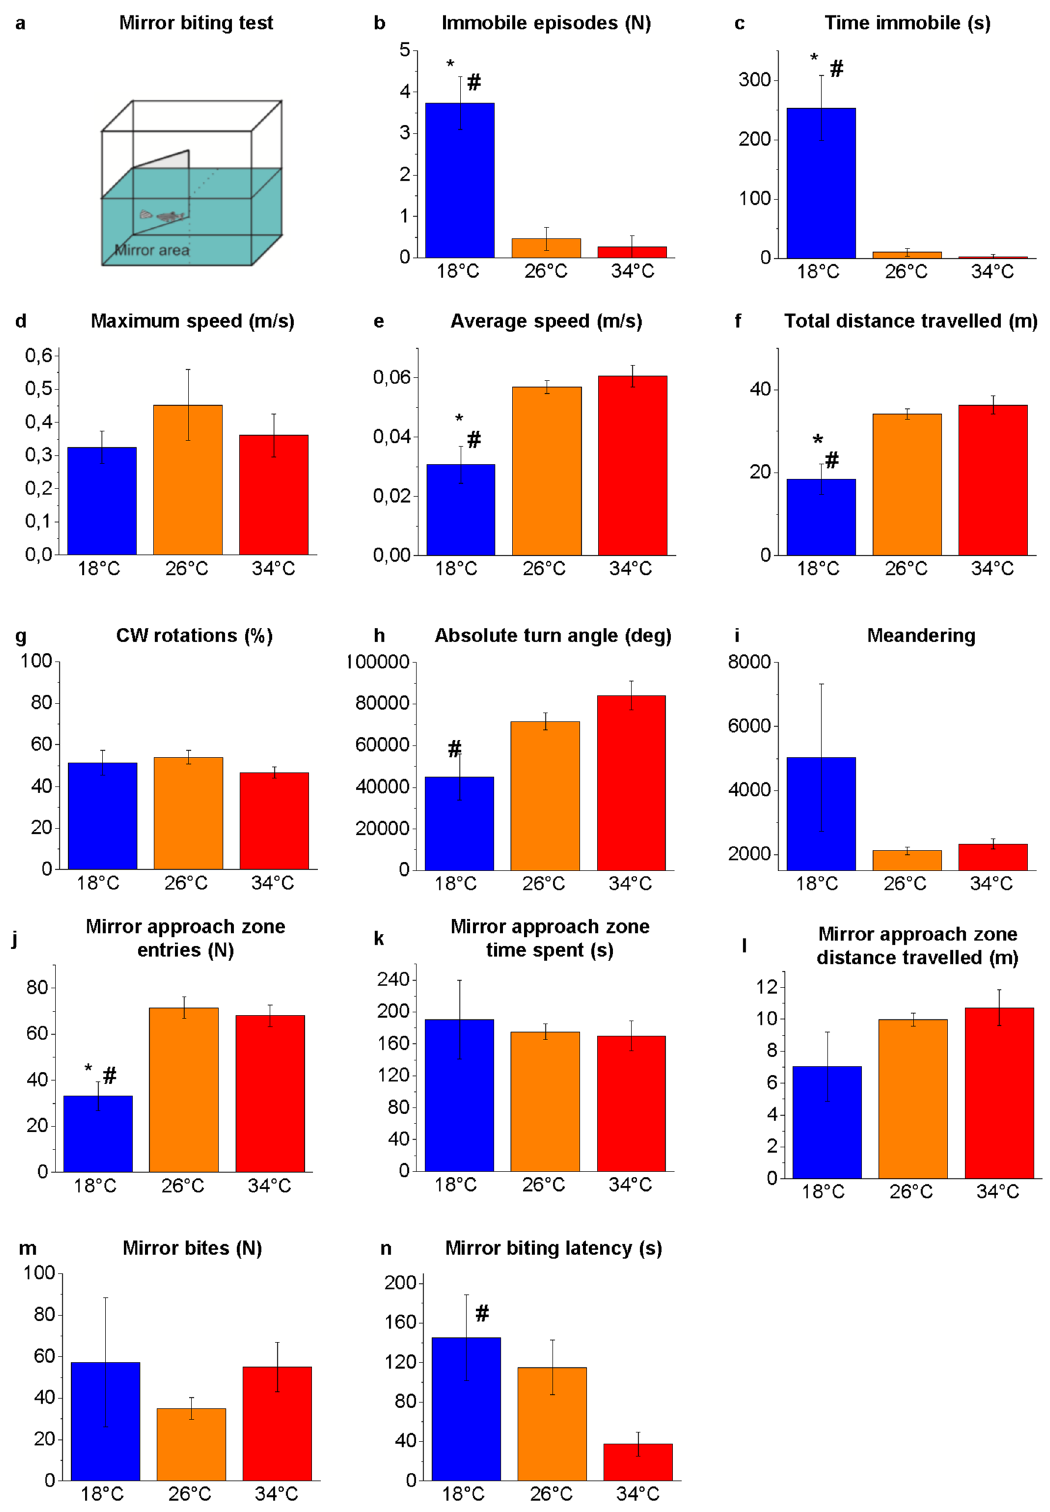
Figure 4. Aggressive behaviour in the MBT. Schematic representation of the apparatus ( a ). Whole-tank analysis: immobile episodes ( b ), time immobile ( c ), maximum speed ( d ), average speed ( e ), total distance travelled ( f ), clockwise (CW) rotations ( g ), absolute turn angle ( h ), and meandering ( i ). Mirror approach area: entries ( j ), time ( k ), total distance travelled ( l ), mirror bites ( m ) and mirror-biting latency ( n ). The data are expressed as mean ± S.E.M. and analysed by one-way ANOVA with Bonferroni post hoc correction. P ≤ 0.05, * 18 °C versus 26 °C; # 18 °C versus 34 °C and $ 34 °C versus 26 °C. P values are reported in Table S5. N =